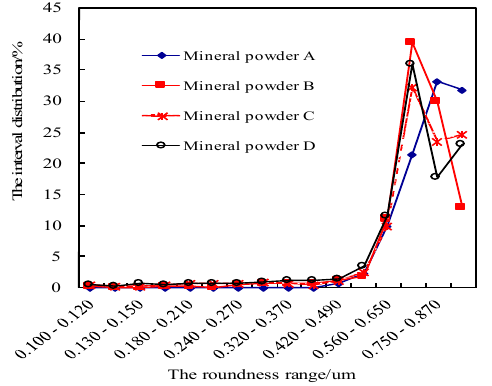
Figure 3. Difference in roundness of the four kinds of mineral powder.